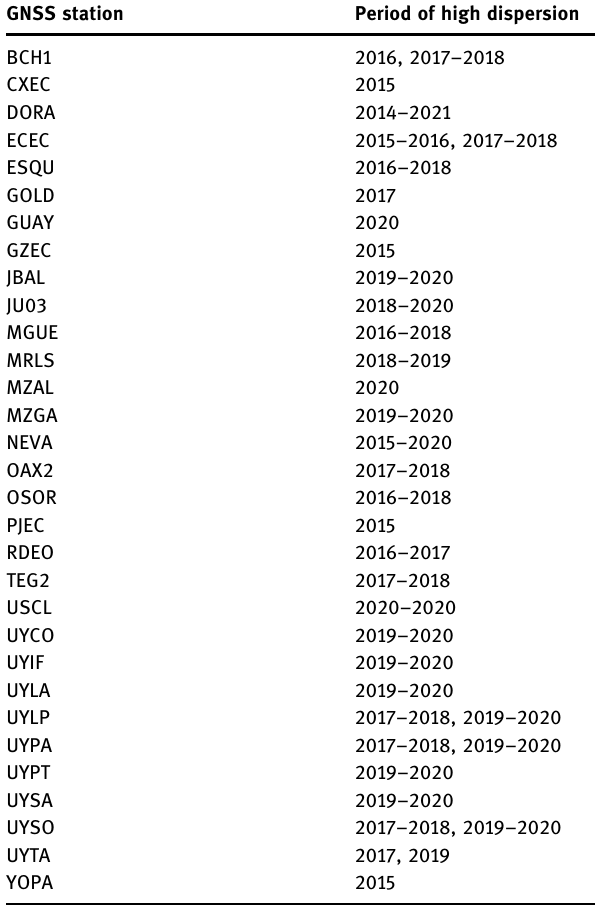
Table 3: GNSS stations with periods of high dispersion in